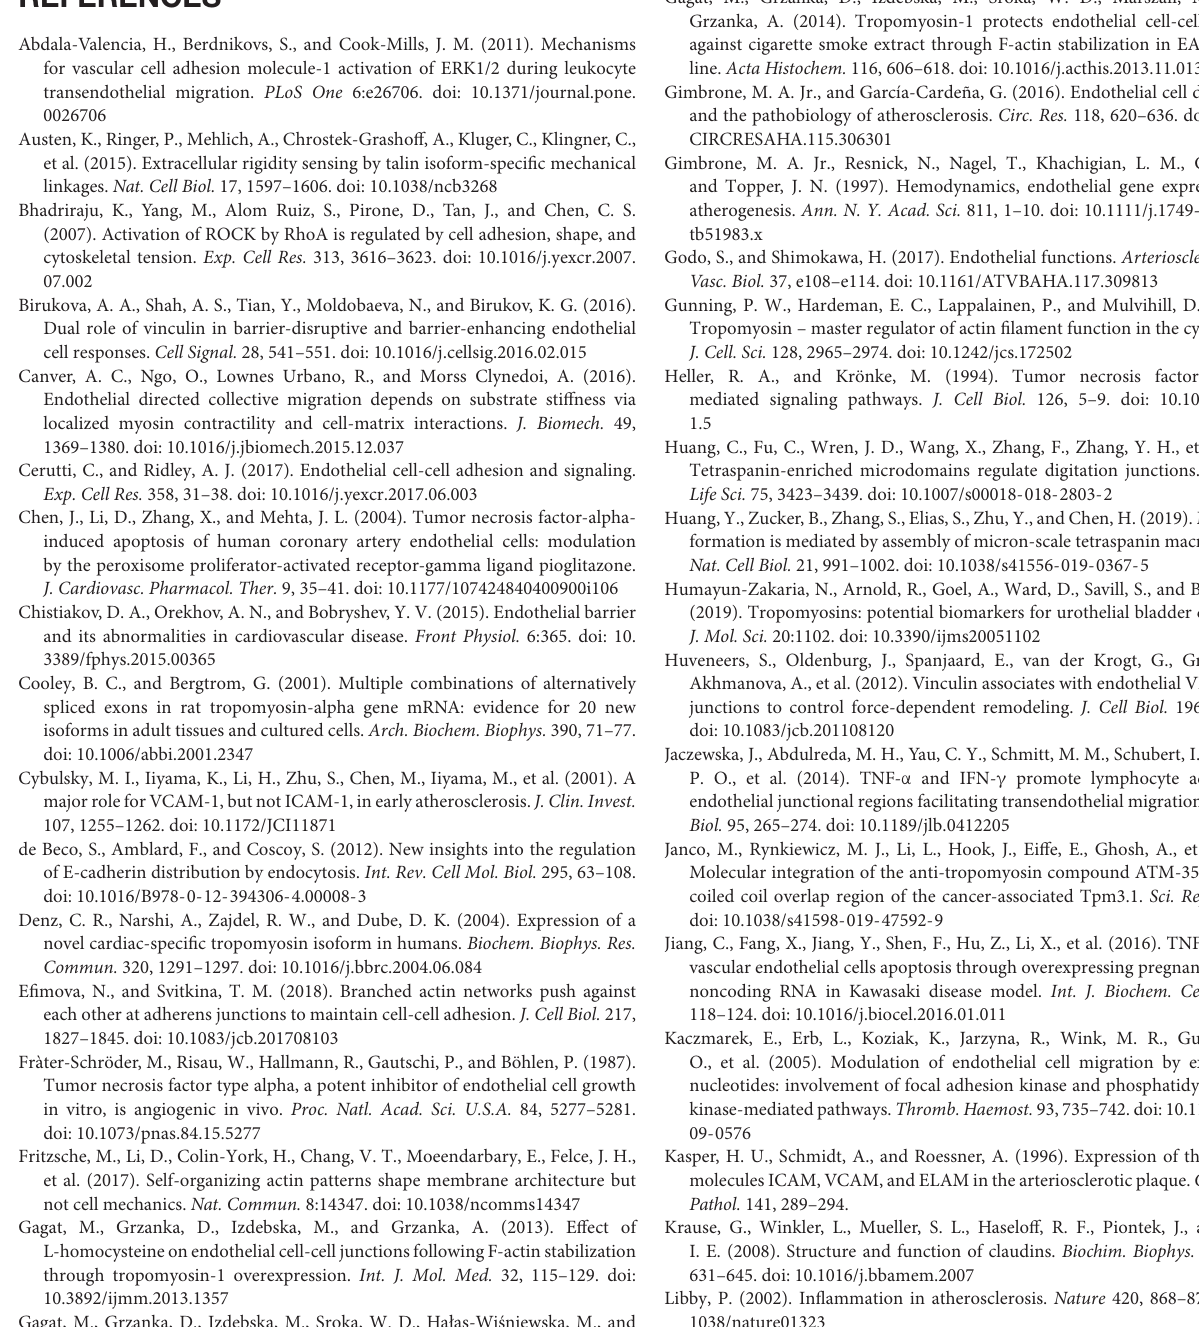
Supplementary Video S6 | TNF α -induced formation of migrasomes and migracytosis. Actin-GFP (red) and talin-RFP (green) were expressed using baculoviruses. TNF α 100 ng/ml refers to cells treated with rh TNF α . Time-lapse images were acquired for 6.5 h at 10-min intervals after 15 h from treatment. Frame rate, 3 frames/s.